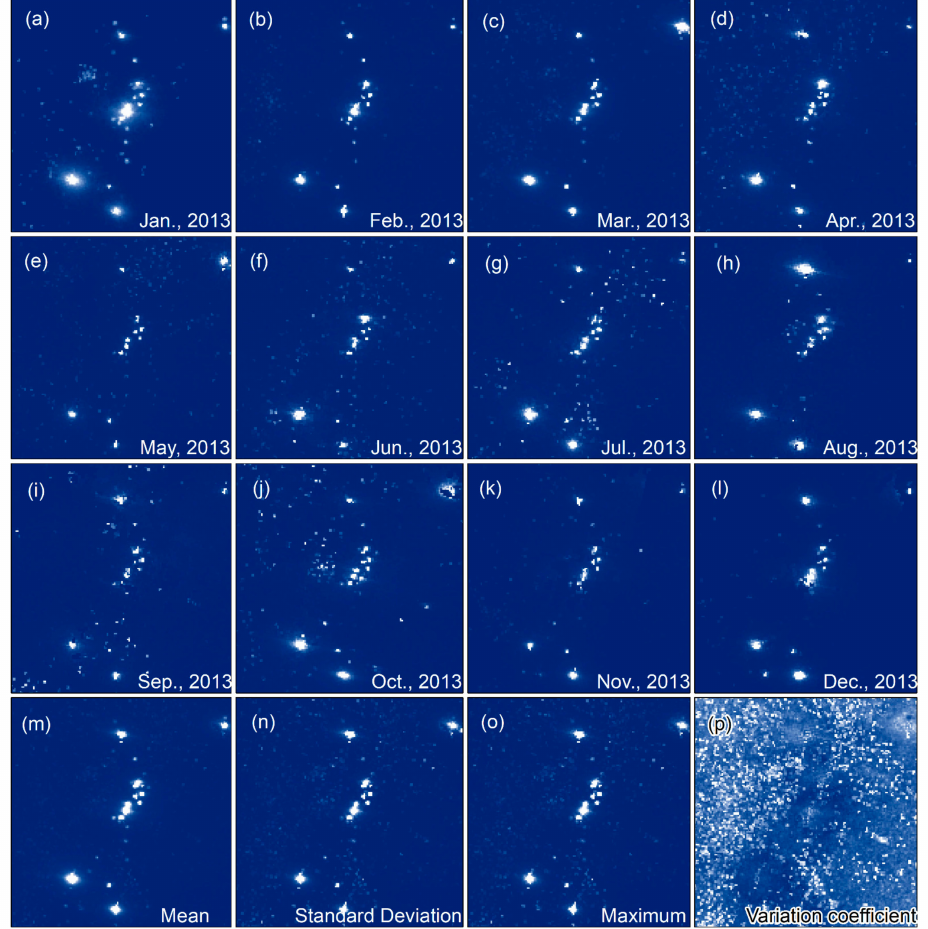
Figure 6. Target brightness feature statistics: ( a – l ) are the normalized results of time-series images; ( m ) is the mean value; ( n ) is the standard deviation; ( o ) is the maximum value; ( p ) is the variation